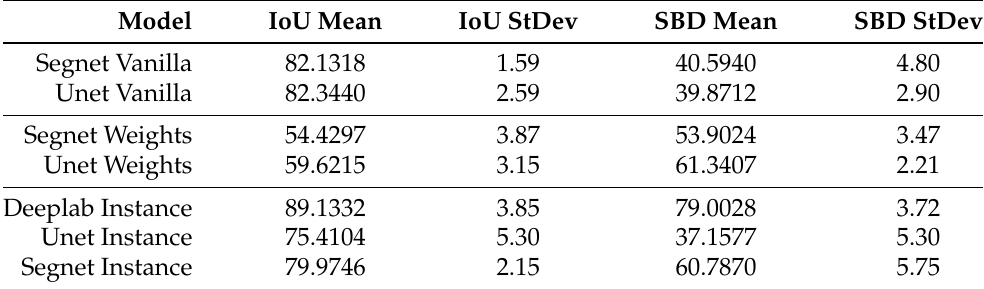
Table 1. Numerical results in terms of IoU and SBD for the three models (UNet, SegNet and DeepLab- v3) and the three strategies (baseline, per-pixel penalty and instance